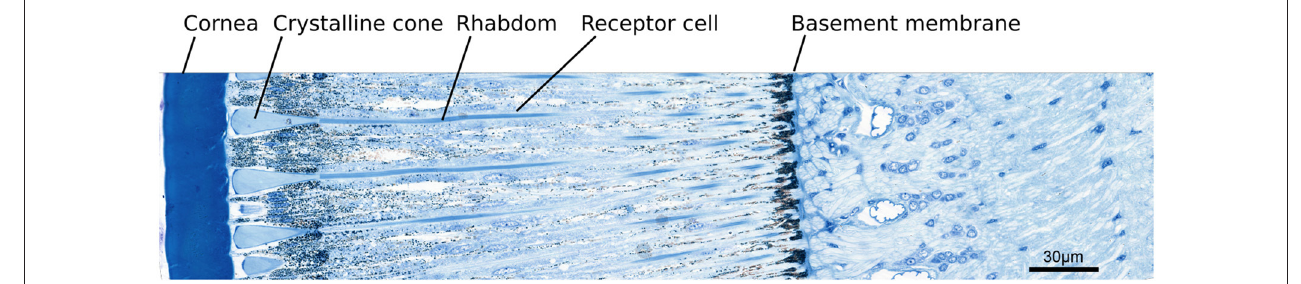
FIGURE 2 | Ommatidia of the honey bee Apis mellifera Linnaeus, 1758 (Apidae), stained. Light passes through the cornea (with corneal facet lenses) and the crystalline cones to the receptor cells that form the rhabdoms. At the basement membrane the optical part of the eye ends. © Stephan Handschuh (2014). Image reproduced with permission.